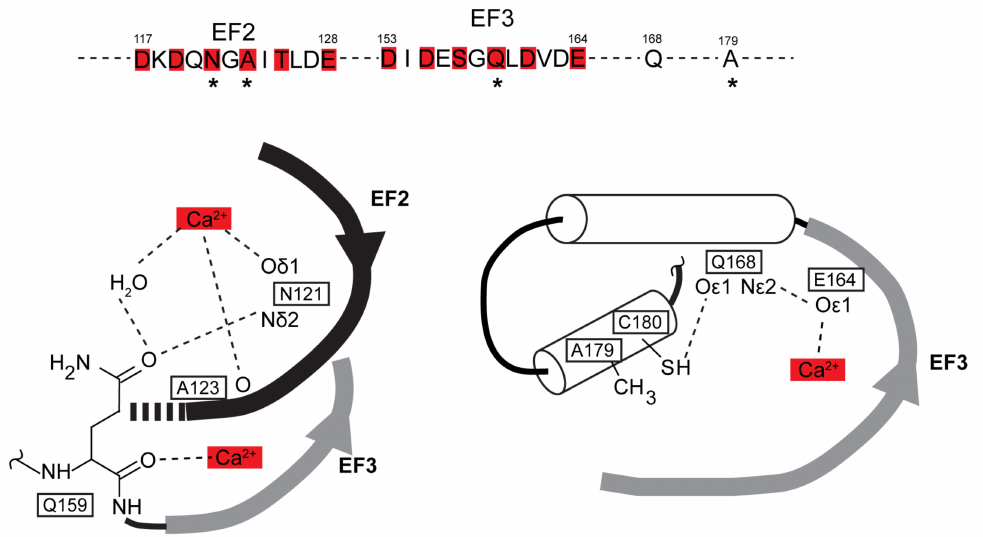
Figure 8. Local environment of amino acid residues bearing AequorinXS mutations N121D, A123D, Q159D / T, and A179T. Upper : position of N121, A123, Q159, and A179 (asterisks) in the